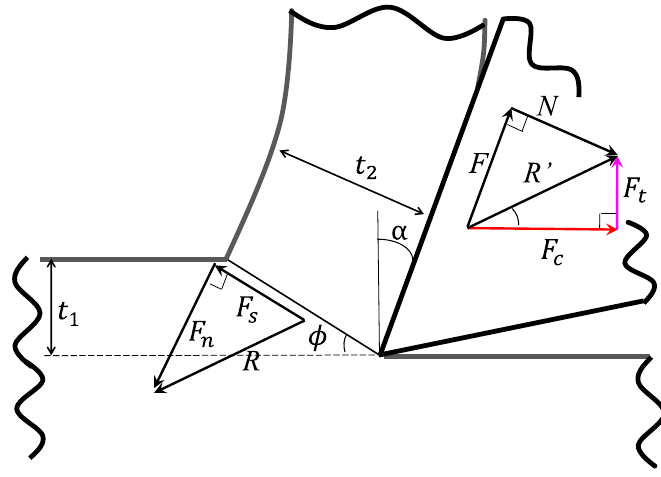
Figure 2. Schematic of an orthogonal cutting.